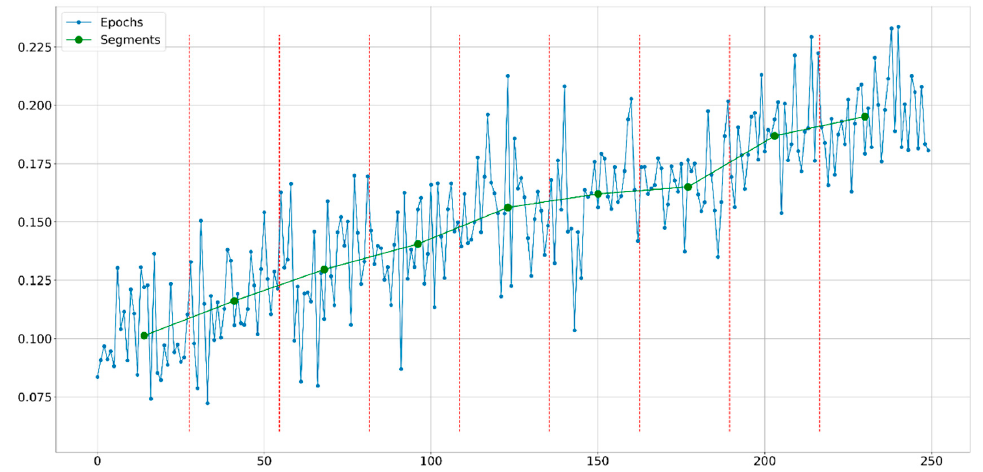
Figure 1. Illustration of segment averaging.